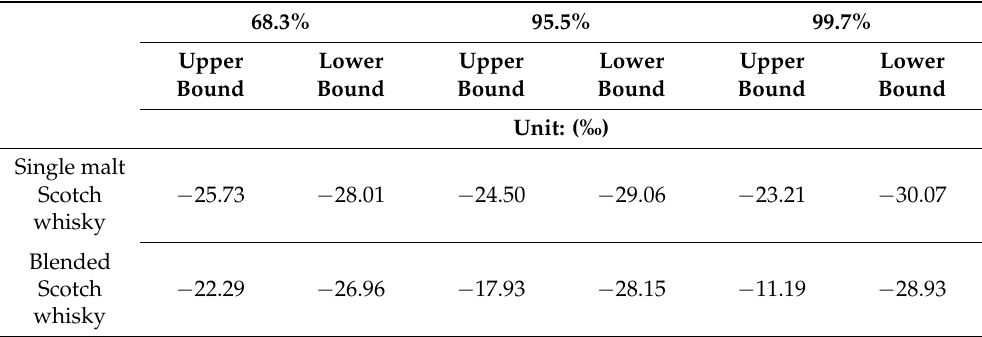
Table 3. Confidence intervals of δ 13 C-ethanol data for authentic Scotch whiskies.